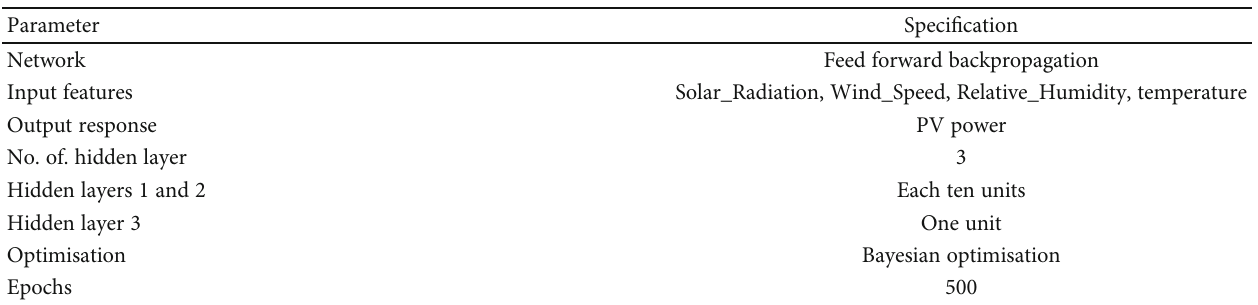
Figure 3: The input and hidden layer fo the Table 1: Parameters of the ANN.